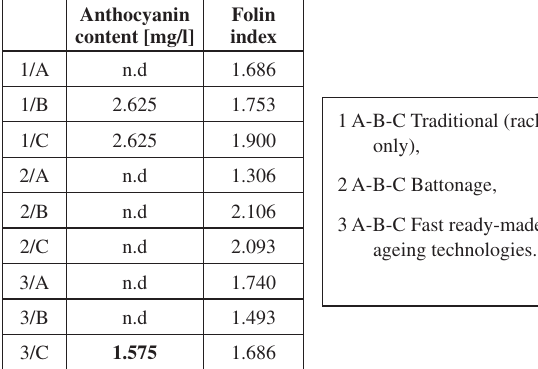
Table 2 Anthocyanin and polyphenol content of the wines in the second survey Anthocyanin content